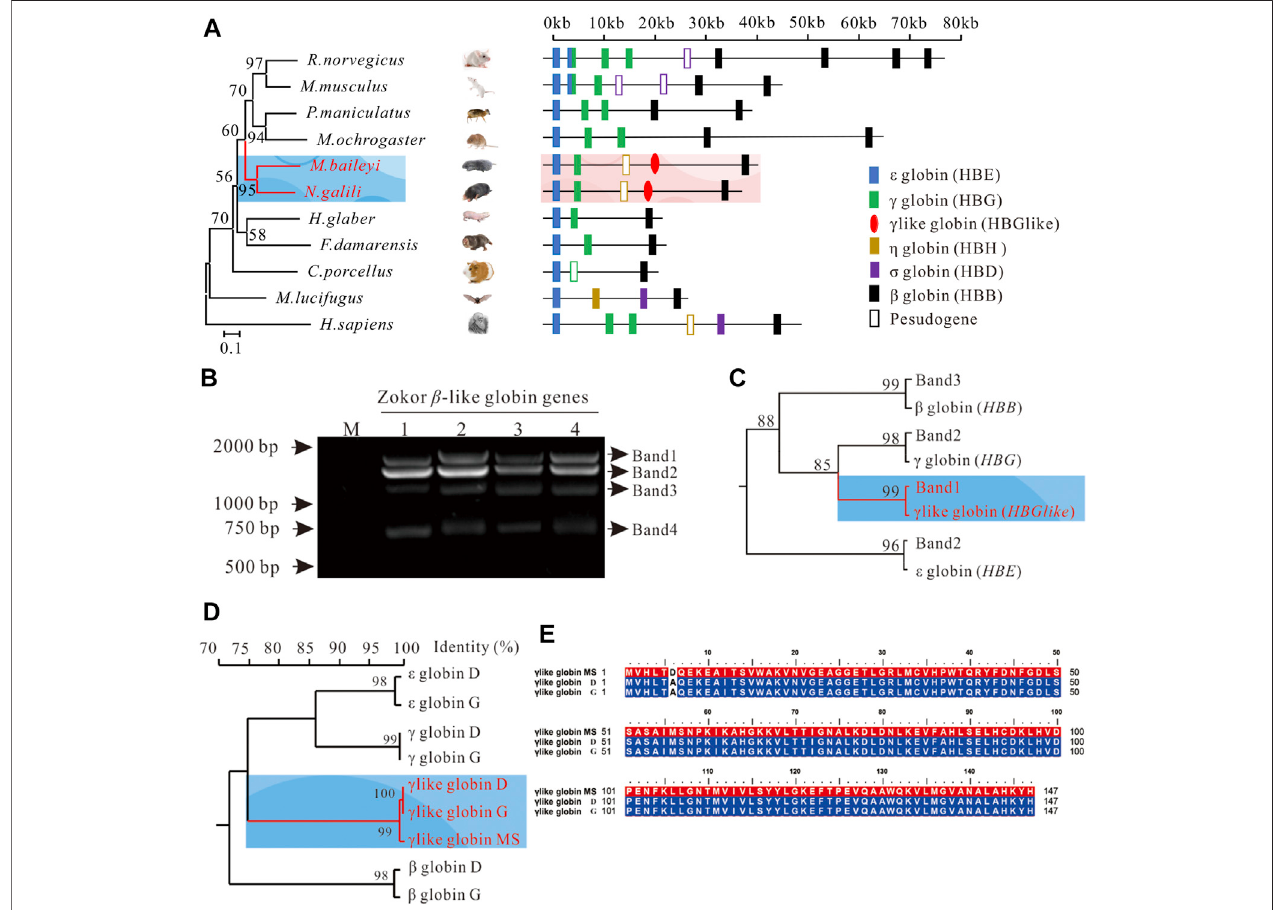
FIGURE 2 | Identi fi cation of the gene encoding the γ -like subunit of plateau zokor. (A) The genomic structures of the β -globin gene clusters in 11 studied placental mammals.Diagonalslashesindicategapsingenomiccoverage.Segmentscontainingsuchgapswerenotdrawntoscale.Theorientationoftheclusterisfrom5 ′ (onthe left) to 3 ′ (on the right). Phylogenetic tree of mtDNA of 11 mammals, inferred by Bayesian inference under the GTR + I + G model. The branch length is shown and the posterior probabilities values (%) are indicated on the nodes. (B) The bands of the cloning β -like globin genes in the lung tissue of plateau zokors by agarose gel electrophoresis. Band-1, -2, -3, and -4 represent the β -like globin genes in the lung tissue of plateau zokors by agarose gel electrophoresis ( n = 4). (C) Maximum likelihood phylograms depicting relationships among β -like globin genes determined by DNA sequencing (Band-1, -2, and -3) and annotated from the β -globin gene clusterbyGenescanandblast2.Bootstrapssupportfortherelevantnodeswasevaluatedusing1,000pseudoreplicates.Thetreedemonstratedthatband-1and-3is γ - likeand β globinandband-2contains γ and ε globin. (D) Thehomologytreeofthe β -likeglobins ’ AAstranslatedfromtheCDSbyDNAsequencing,annotatedfromthe β - globin gene cluster, and the AAs detected by the MS assay. The tree was constructed by DNAMAN version 9.0. (E) The homology alignments among the γ -like globin sequencedetectedbyMS( γ -likeglobinMS),translatedfromtheCDSbyDNAsequencing( γ -likeglobinD)andannotatedfromthe β -globingeneclusterofplateauzokor ( γ -like globin